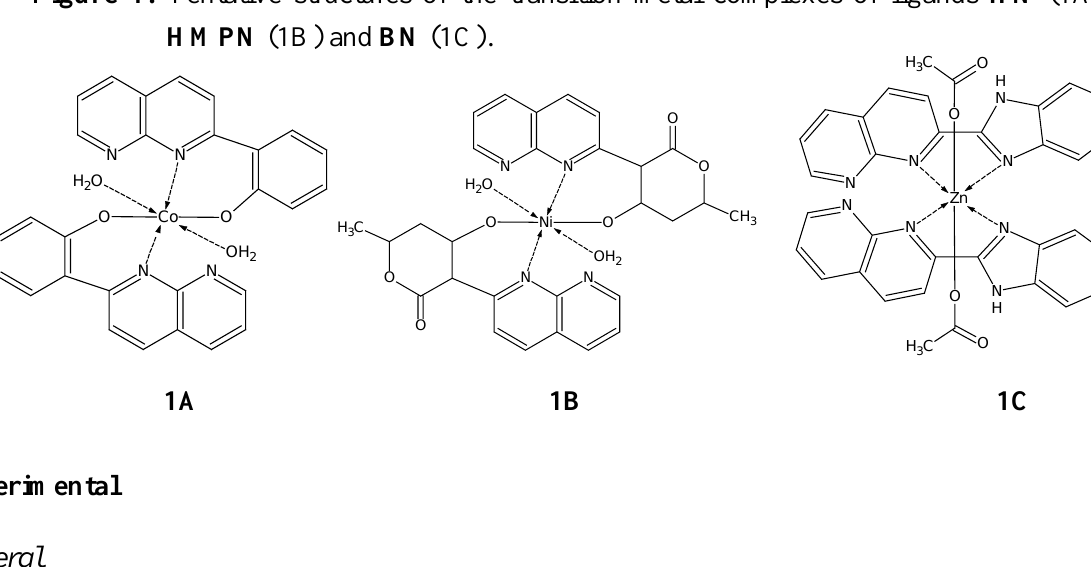
Figure 1: Tentative structures of the transition metal complexes of ligands HN (1A), HMPN (1B) and BN